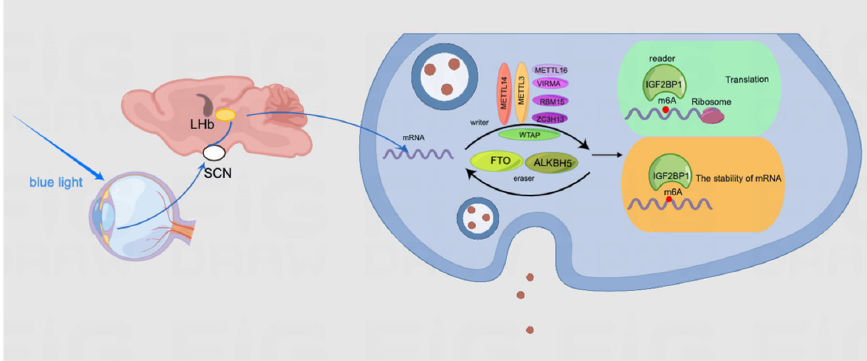
Figure 10. Blue light is delivered to the LHb via the SCN pacemaker after it is accepted by melanopsin in the retina, where m6A methylation of genes related to synaptic function is abnormal. Therefore, blue light exposure may disrupt the translation process of related genes as well as mRNA stability through m6A modification processes.